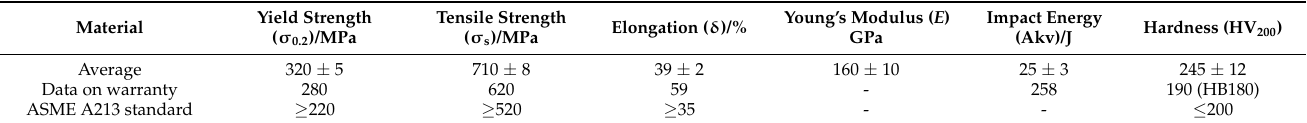
Table 1. Mechanical properties of